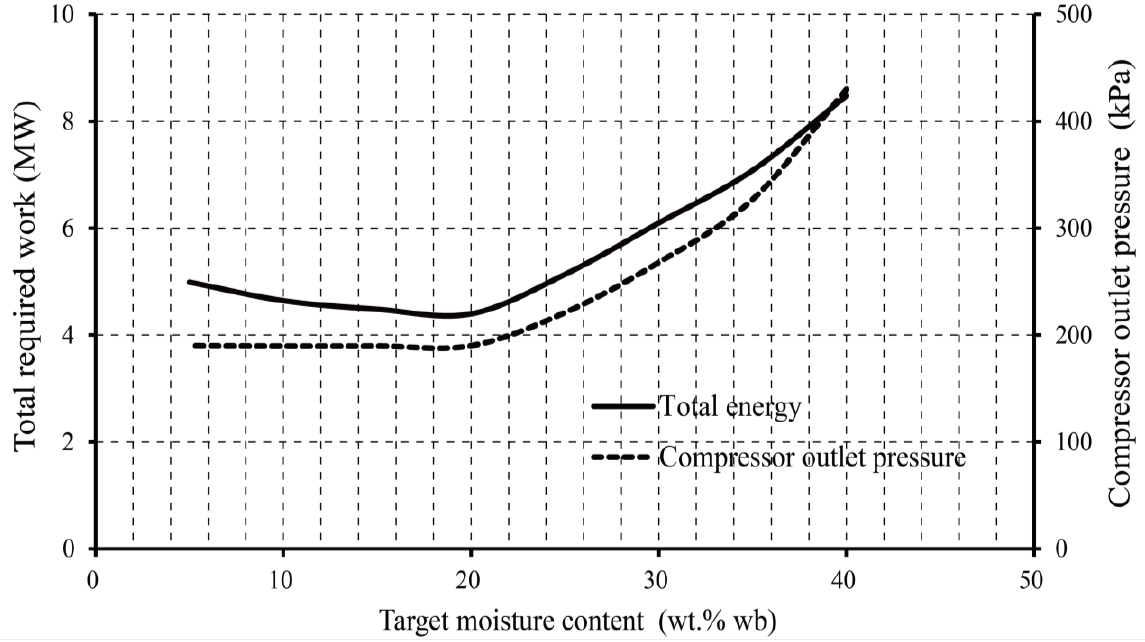
Figure 5. Correlation between the total required energy and compressor outlet pressure with the target moisture